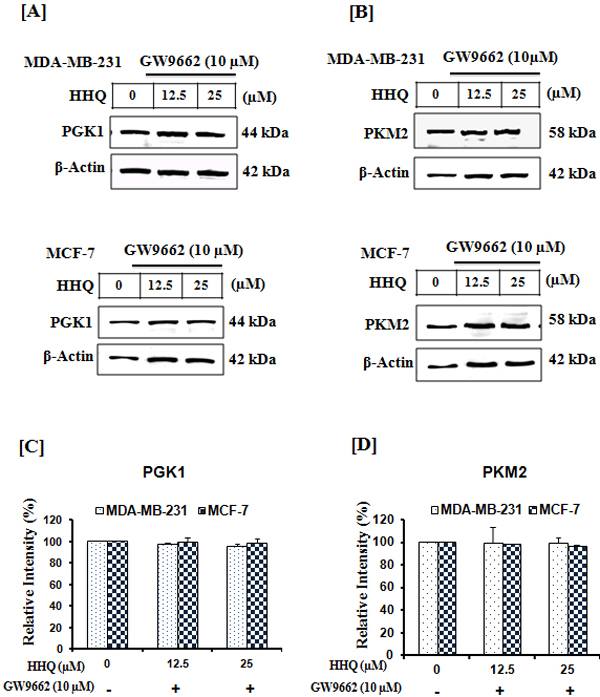
PPARγ dependent repression of glycolytic enzymes PGK1 and PKM2 by HHQ in human breast cancer cells, MDA-MB-231 and MCF-7. The breast cancer cells were pre-treated with a potent PPARγ antagonist, GW9962 (10 μM) for 4 h at 37 °C, followed by treatment with 12.5 μM and 25 μM of HHQ for 48 h at 37 °C. Representative western blot hybridization signals for PGK1 [A] and PKM2 [B] for both the breast cancer cell lines and the quantitation of the signals is shown in [C] and [D], respectively. GW9662 showed no effect of HHQ on expression of PGK1 and PKM2, thereby suggesting that the activation of PPARγ is required for repression of these enzymes. Data are representative of three independent experiments and expressed as mean ± S.E.M.